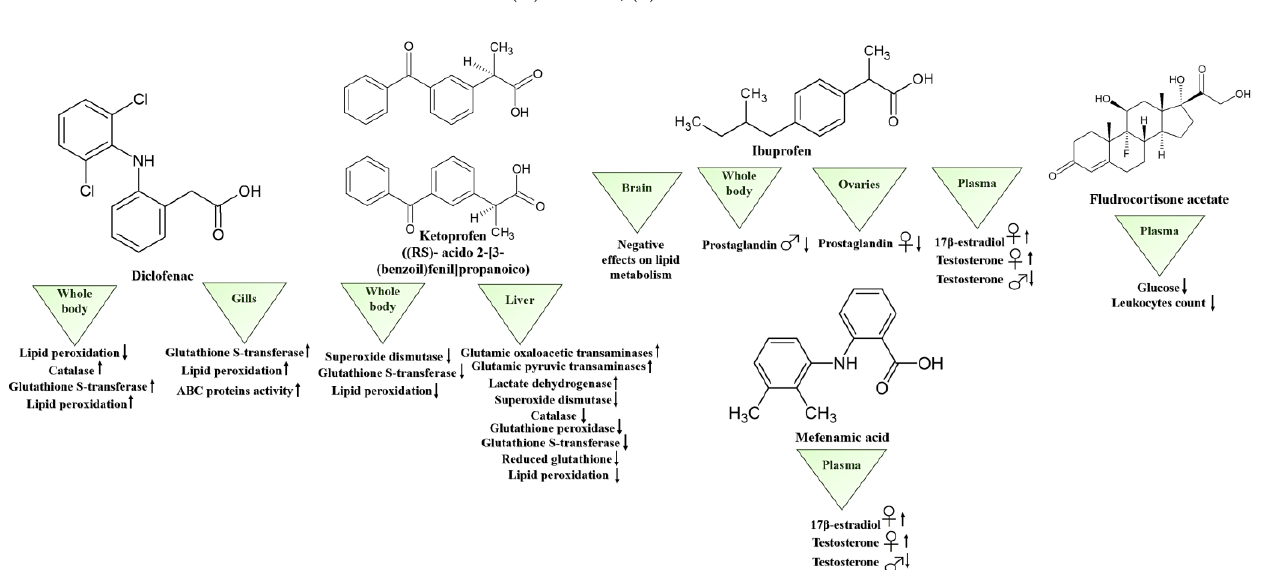
Figure 4. Schematic representation of the effects of analgesic, antipyretic and anti-inflammatory drugs on the biochemical responses of D. rerio adults. The arrow pointing up indicates “up-regulation” while the arrow pointing down indicates “down-regulation”. Table 4. Biochemical responses in zebrafish exposed to analgesic, antipyretic and anti-inflammatory drugs. Drug